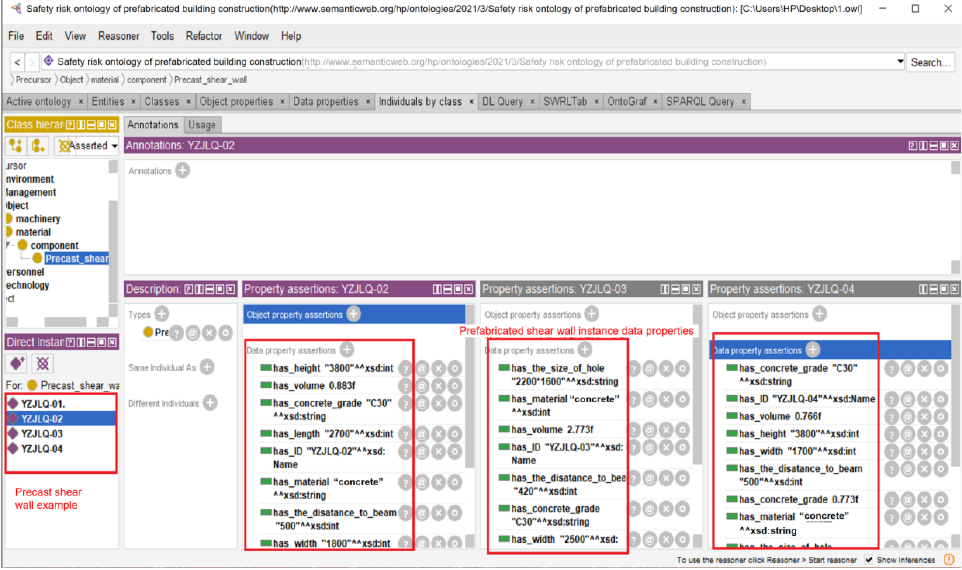
Figure 12. IFC file export process.